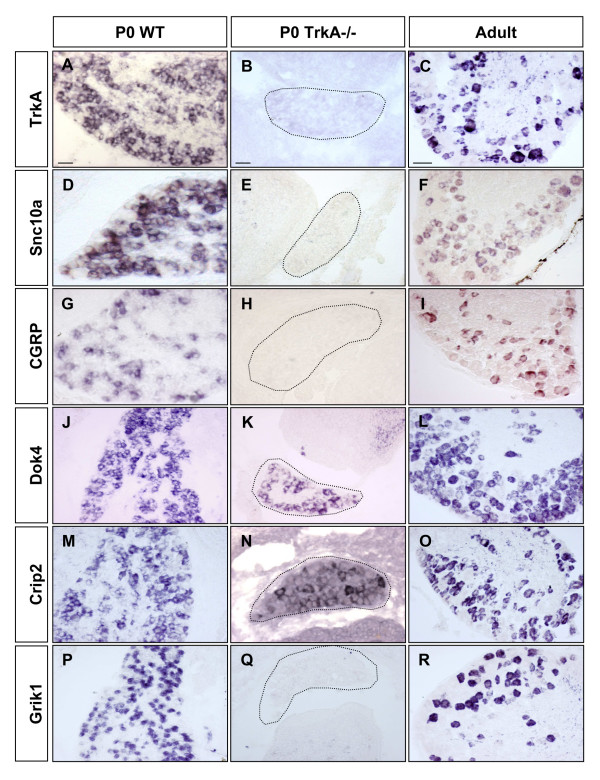
In situ hybridization patterns of selected genes: In situ hybridization on cryostat section of P0 Wild type (A, D, G, J, M, P), P0 TrkA mutant (B, E, H, K, N, Q) and adult (C, F, I, L, O, R) with DIG-labelled probes for TrkA (A, B, C); Scn10a (D, E, F); CGRP (G, H, I); Dok4 (J, K, L); Crip2 (M, N, O) and Grik1/GluR5 (P, Q, R). Arrows in L and O indicate unlabelled cells. TrkA mutant DRGs are encircled in B, E, H, K, N and Q. Data show that Dok4 was expressed in the majority of neurons, scattered negative cells was observed, arrows in L. Crip2 was widely expressed, although substantial numbers of negative cells were noted, arrows in O. Grik1/GluR5 was expressed in sub-population of neurons and was completely absent from TrkA mutant DRG. Scale bar 50 μm.